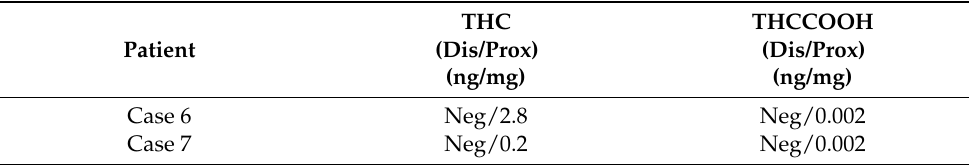
Table 5. THC and THCCOOH hair analyses results from patients 6 and